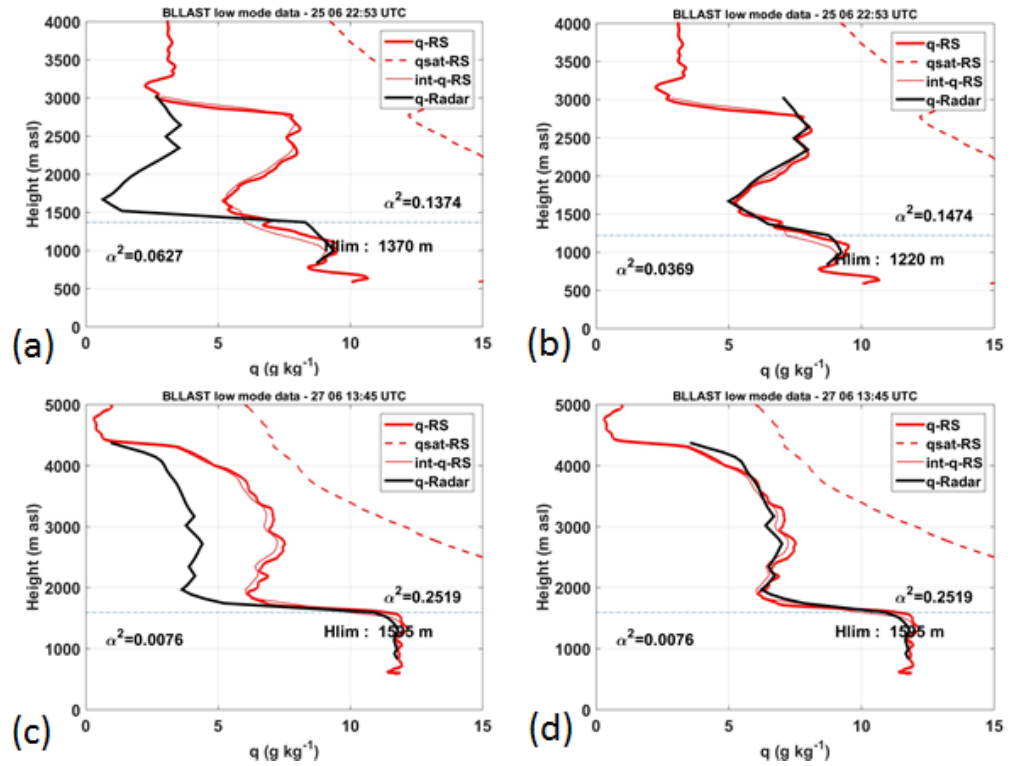
Figure 3. Specific humidity profiles obtained for two different profiles from the BLLAST data set, using an automatic detection of the initial specific humidity value ( q o ) at the level z o , where the integration is initialized (a, c) and through an adjustment of q o (b, d) . The vertical resolution is 75m. Same details as in Fig. 1c.